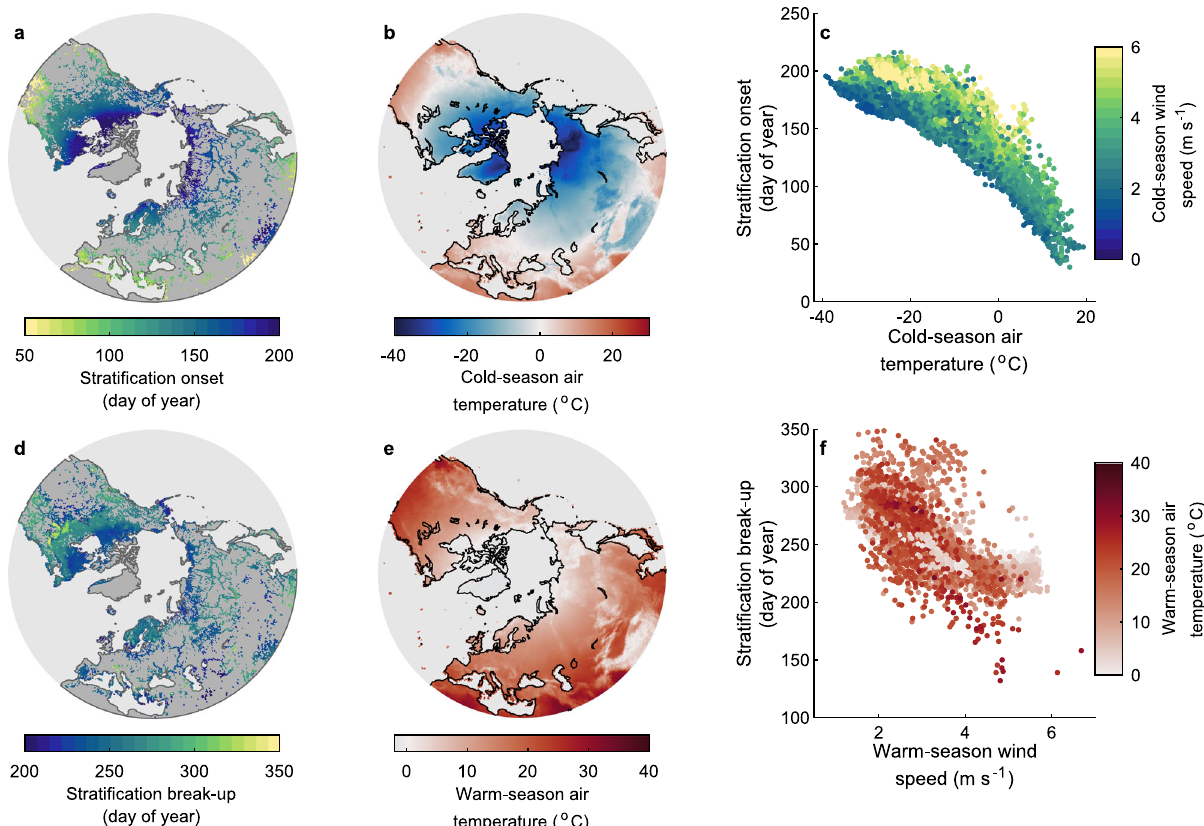
Fig. 1 Simulations of lake strati fi cation phenology across the Northern Hemisphere. Shown are the historic, averaged over all years from 1970 to 1999, spatial patterns in a the day of year of strati fi cation onset, b the cold-season (November – April) average air temperature, and c the relationship between strati fi cation onset, the cold – season air temperature, and wind speed. Also shown are the spatial patterns in d the day of year of strati fi cation break-up, e the warm-season (May – October) average air temperature, and f the relationship between strati fi cation break-up, the warm-season air temperature, and wind speed. All results are based on the average simulations across the lake – climate model